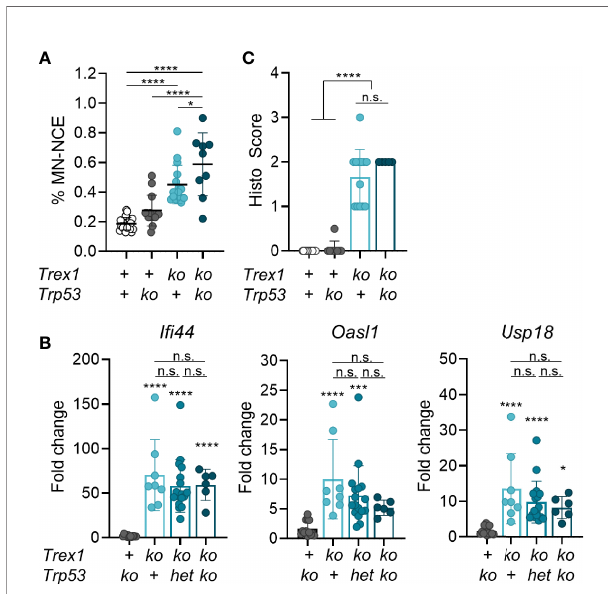
FIGURE 1 | Mild genome damage, but no amelioration of the in fl ammatory phenotype of Trex1 -/- mice lacking also p53. (A) Flow cytometric quanti fi cation of micronucleated erythrocytes from 6 week-old mice of the indicated genotypes (WT n = 22, Trp53 -/- n = 14, Trex1 -/- n = 16, Trp53 -/- Trex1 -/- n = 9). See Figure S1 for gating strategy. The Trex1 null allele published by Morita et al. was used (23). (B) ISG transcript levels in total blood cells quanti fi ed by qRT-PCR. Fold change compared with mean of WT controls (n = 16) is shown. Trp53 -/- n = 13, Trex1 -/- n = 8, Trex1 -/- Trp53 WT/- n = 17, Trex1 -/- Trp53 -/- n = 6. (C) Quanti fi cation of myocarditis intensity in H&E-stained sections of heart tissue from 6-10 week-old mice of the indicated genotypes (WT n = 11, Trp53 -/- n = 9, Trex1 -/- n = 12, Trex1 -/- Trp53 -/- n = 5; see M&M for heart in fl ammation score). ****p < 0.0001, ***p < 0.001, *p < 0.05, n.s., not signi fi